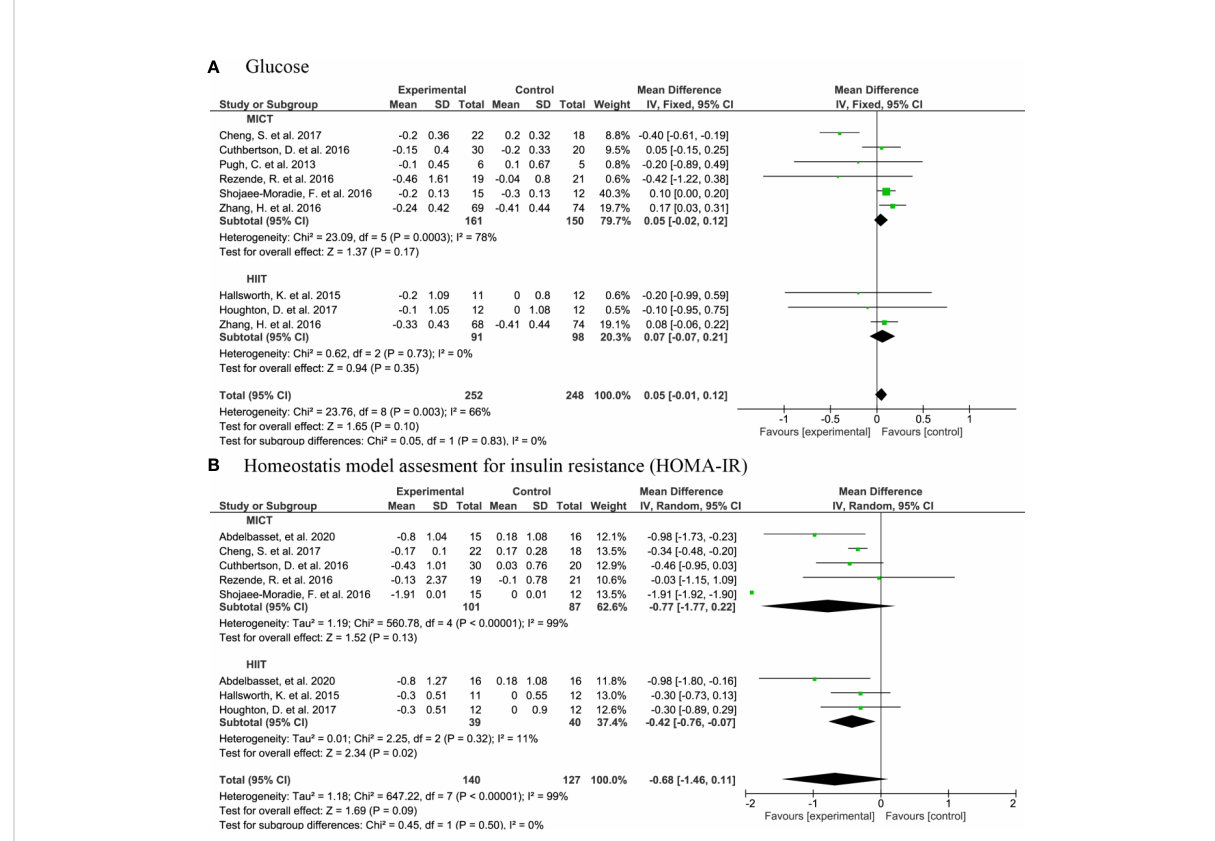
FIGURE 7 Forrest plot for the effect of moderate-intensity continuous training (MICT) and high-intensity interval training (HIIT) on: (A) glucose; (B) homeostatic Model Assessment for Insulin Resistance